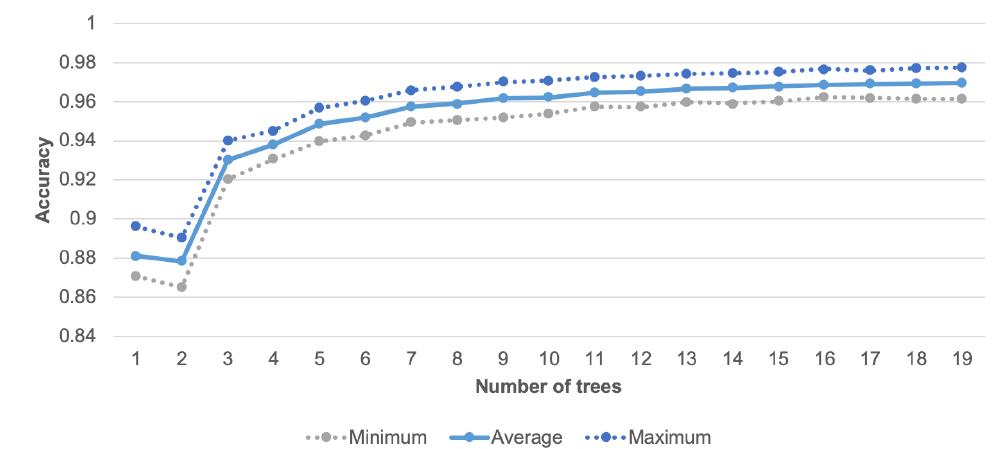
Figure 8. Accuracy of human activity recognition for different number of